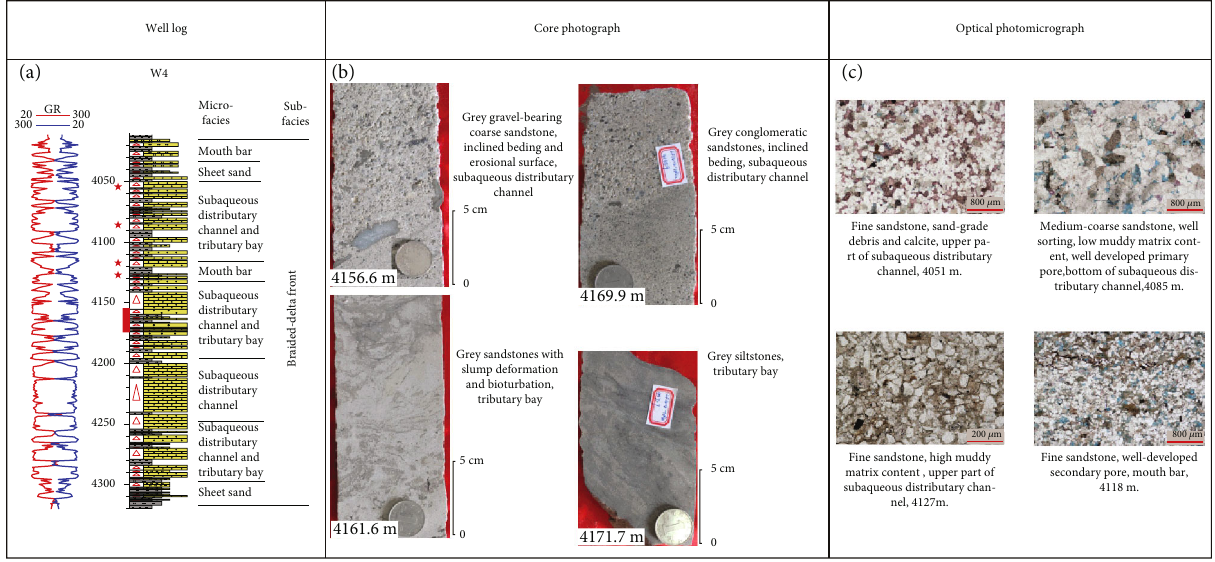
Figure 4: Typical logging curves (a), core photos (b), and optical photomicrograph (c) show the braided-delta front characteristics, especially the subaqueous distributary channels and mouth bar. The well location is marked in Figure